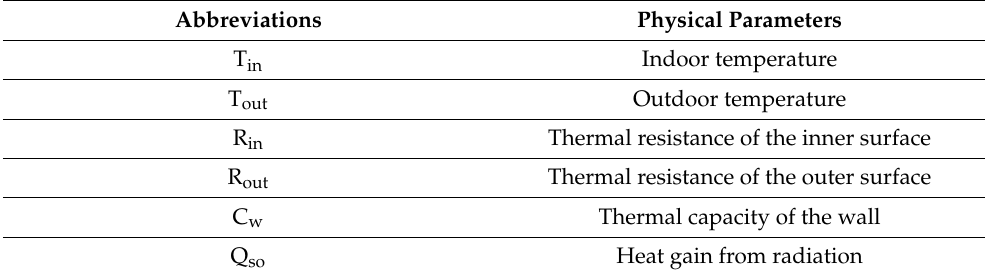
Table 6. Physical parameters in RC